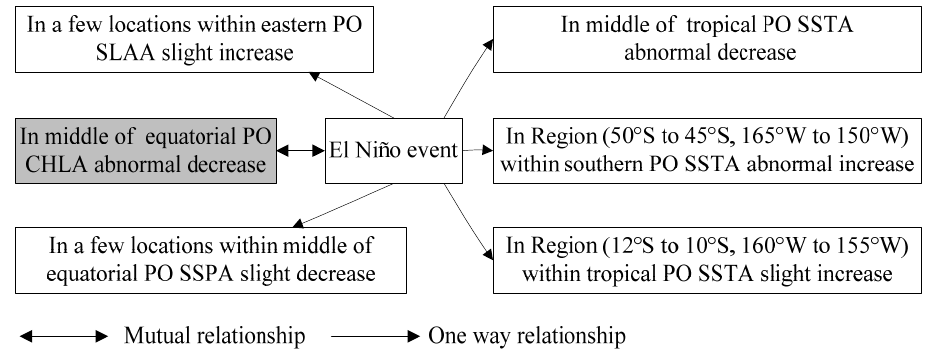
Figure 6. Association patterns network for El Niño events and marine environmental parameters. The mutual relationship and one-way relationship have the same meanings as Figure 5.